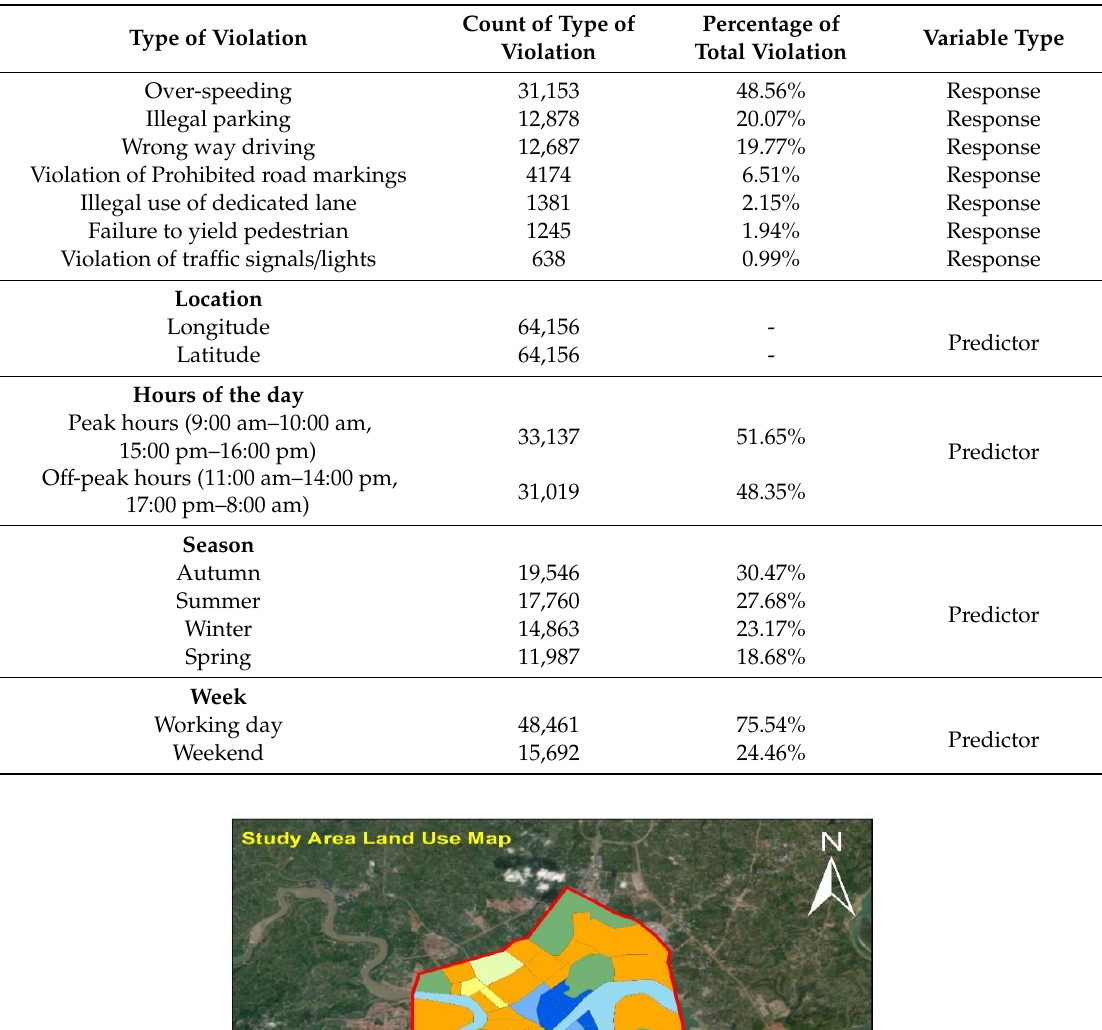
Table 1. Descriptive statistics of the violation samples ( N = 64,156) .